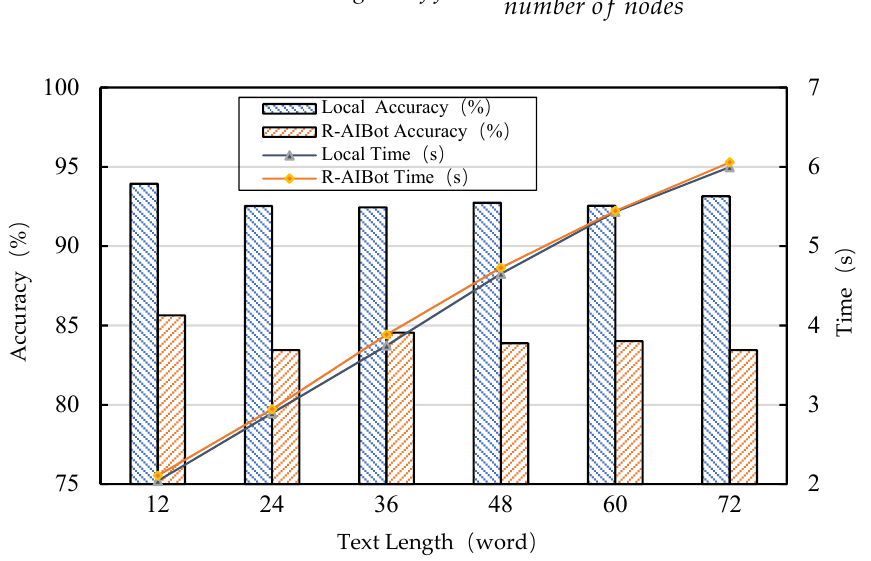
Figure 16. Variation in accuracy and execution time with text length.